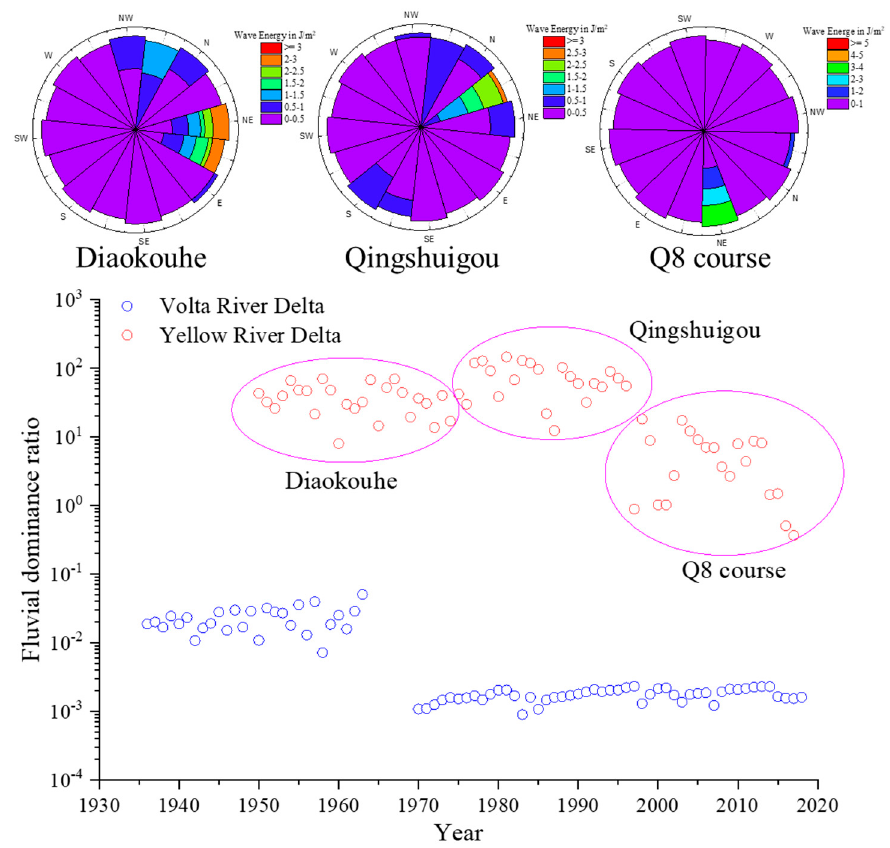
Figure 8. Fluvial dominance ratio of the Volta River Delta and Yellow River Delta. Note that the circles represent the channel shifts of the Yellow River Delta.